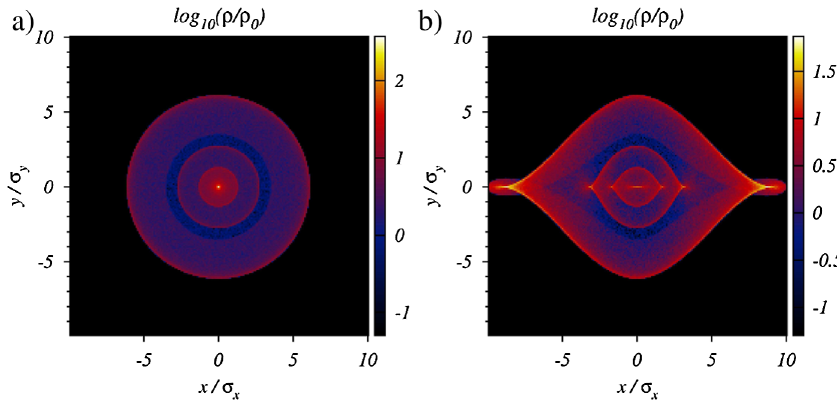
FIG. 2. (Color) Electron density enhancement in the transverse plane (in units of proton bunch sizes) at z ¼ 1 (cid:2) z without field (left) and in a dipole (right).